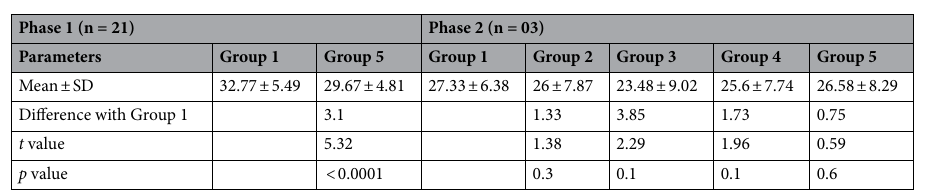
Table 5. Statistical analysis (paired t test) of the results between 20 and 40 ng/mL for the different groups in Phase 1 and Phase 2